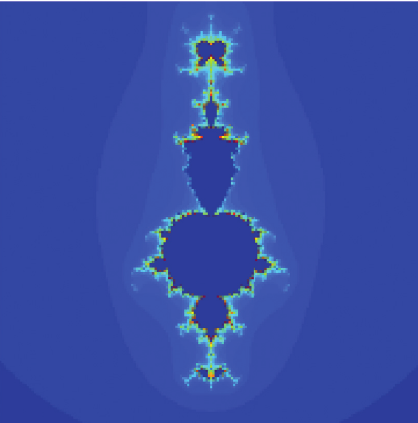
Figure 9: The general Mandelbrot set P � √ ( i / , 0 ) 3